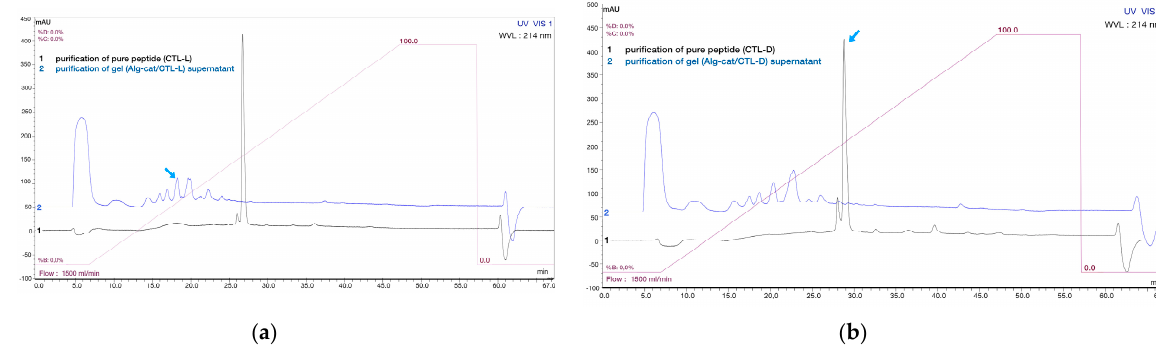
Figure A1. HPLC analysis of CTL (at + 24 h). Black curves ( 1 ) show a main peak corresponding to the reduced and active form of L-CTL ( a ) and D-CTL ( b ). Profiles of curves are similar between L and D-CTL. Blue curves ( 2 ) display a main peak (salts), followed by several secondaries (seven) peaks that correspond to peptides in the supernatant of the gel after 24 h (and it is similar after 7 days). The complete characterization of the fragments indicated by blue arrows ( ↓ ) is obtained with MALDI–TOF analysis (Appendix A Figure